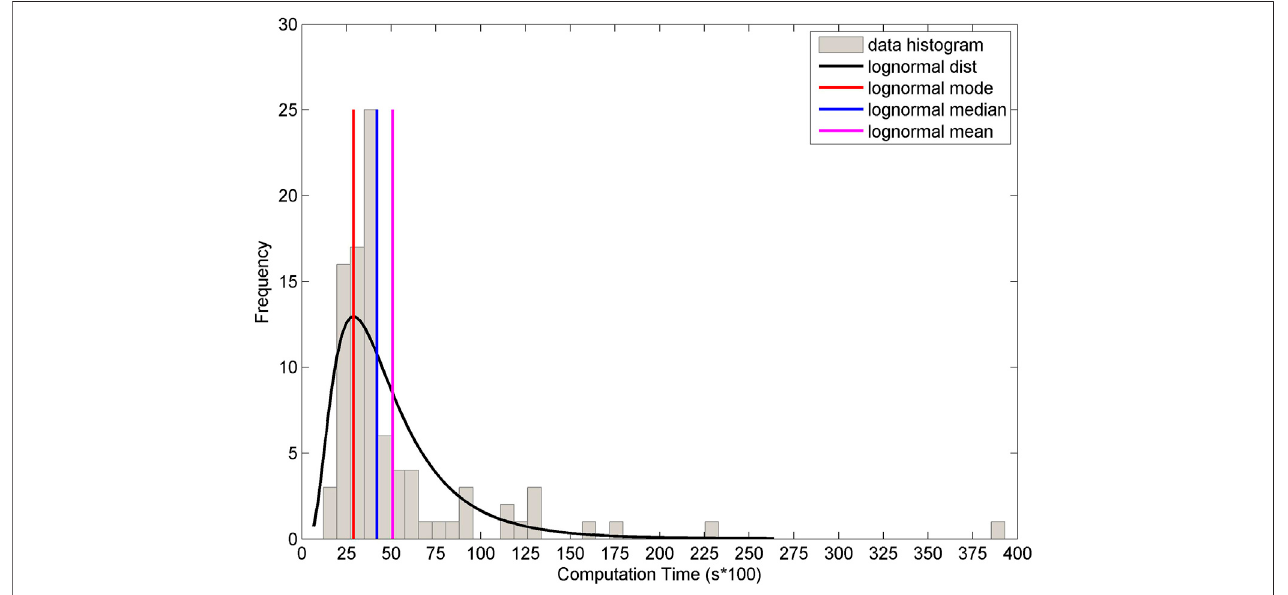
FIGURE 3 | Statistic of the computation time